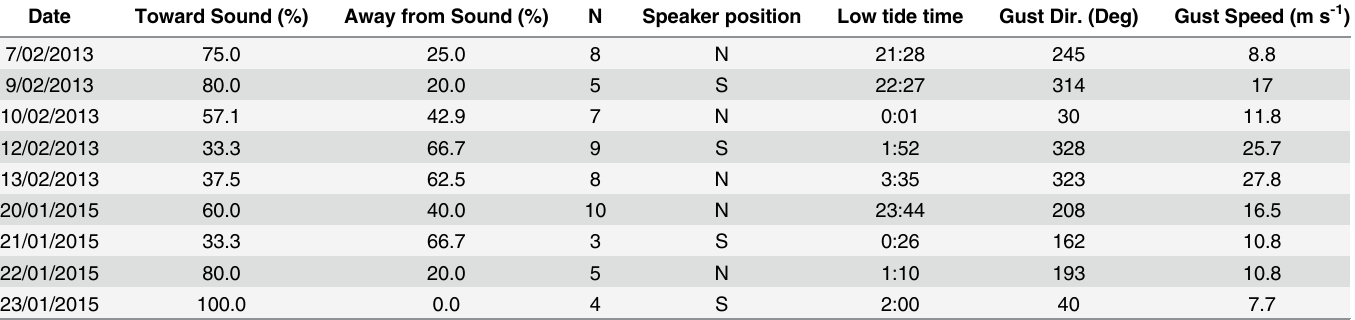
Table 1. Directional choice of Jasus edwardsii pueruli in the behavioural choice chamber (towards or away from the artificial sound), position of the speaker, and ambient environmental variables at the experimental site (timing of low tide, gust wind direction and speed).